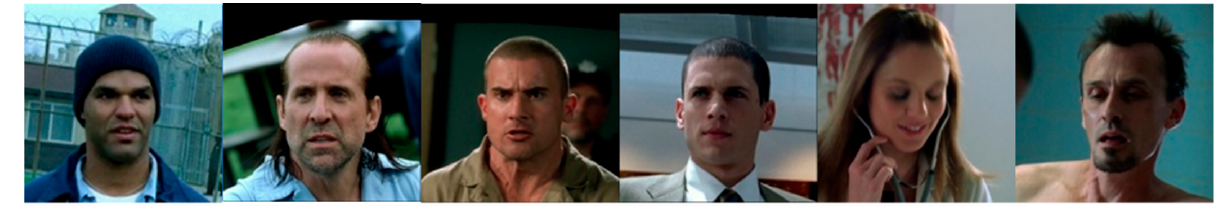
Figure 4. Samples from ICT-PB [52].